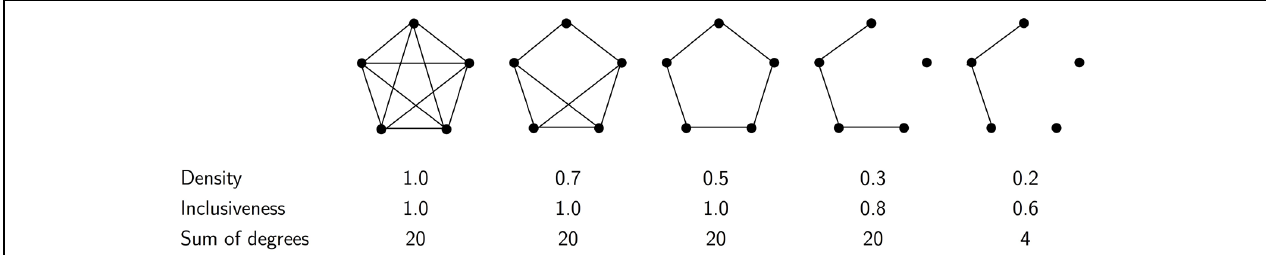
FIGURE 1 | Relation between density and inclusiveness of social networks (figure design inspired by Scott, 2012, p. 71).